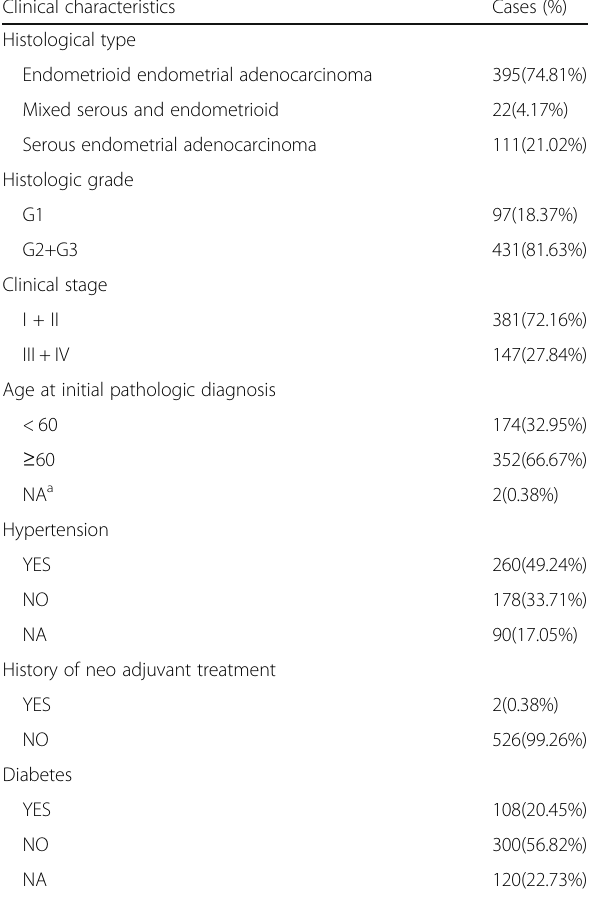
Table 1 Clinical characteristics of patients with endometrial cancer Clinical